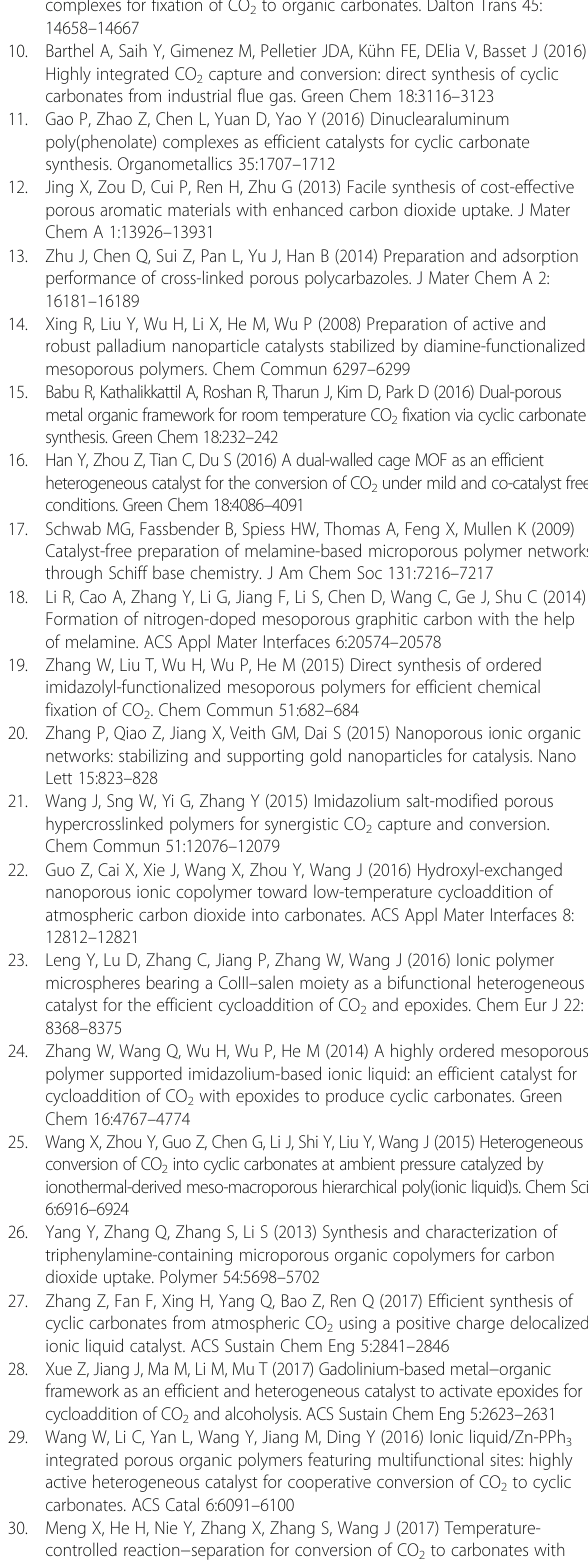
TEA. Figure S5. GC spectrum for the cycloaddition reaction of CO 2 with cyclohexene oxide over TPDB-BP-TEA. (DOCX 598